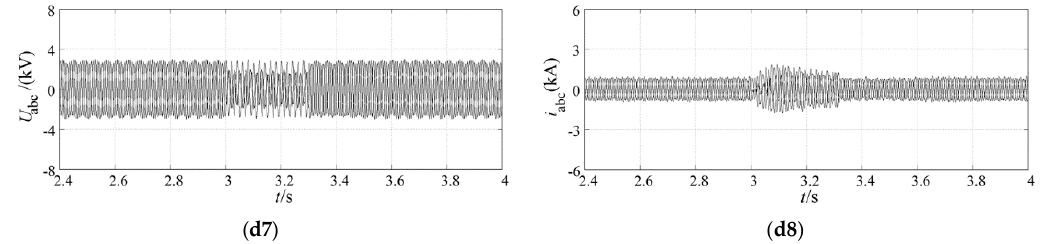
Figure 8. Simulation results of single-phase-to-ground grid fault condition under different controllers.